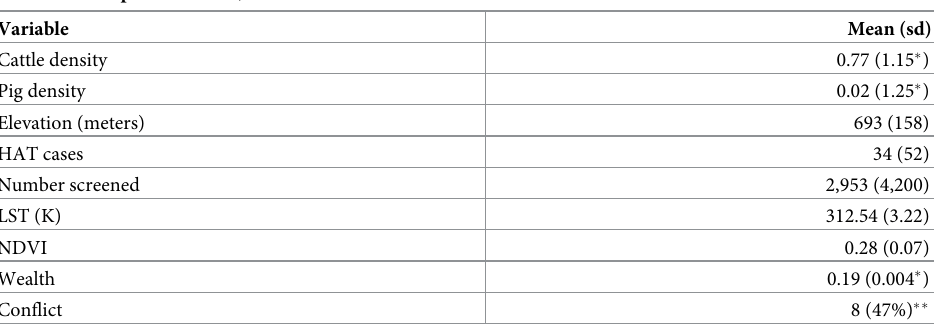
Table 2. Descriptive statistics, South Sudan.